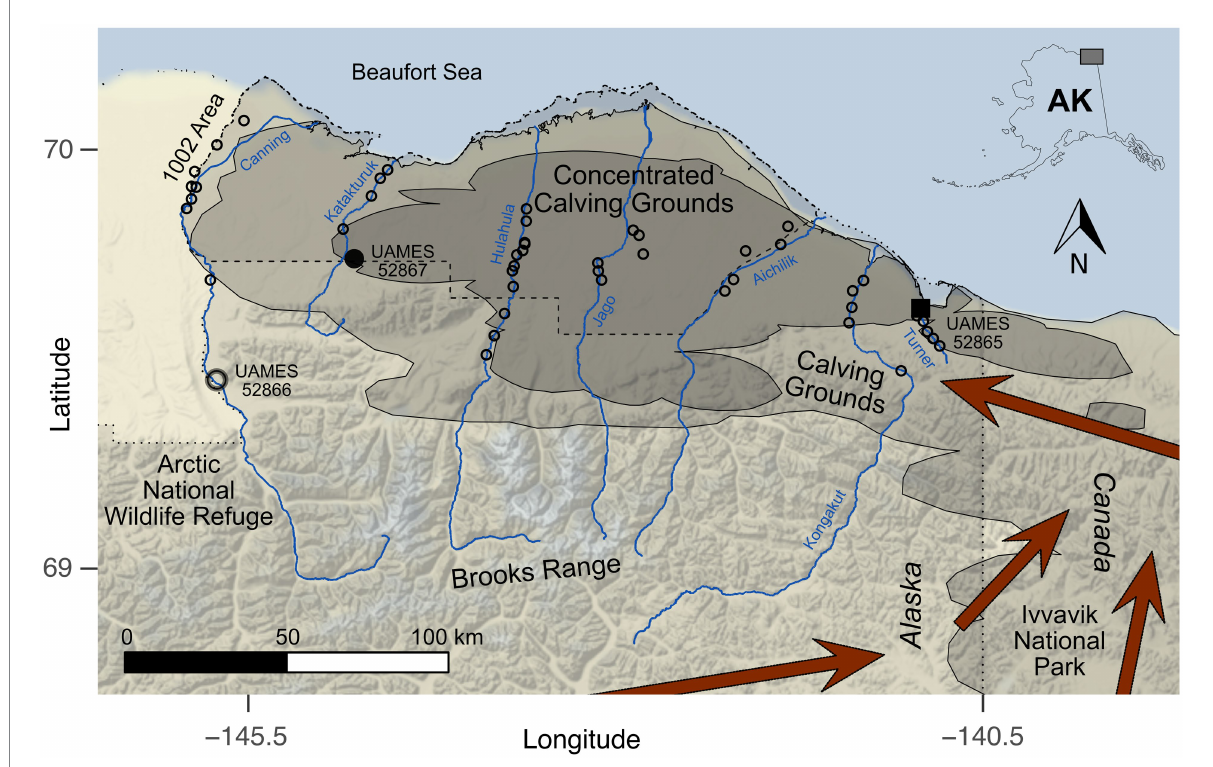
FIGURE 1 Map of the calving grounds (Alaskan) and nearby environments for the Porcupine Caribou Herd (PCH). Demarcation of the PCH calving grounds (lightly shaded region) and concentrated calving grounds (darker shaded region) are based on monitoring records (Griffith et al., 2002; Caikoski, 2020). Boundary of the Arctic National Wildlife Refuge and the “1002 Area” identified by dotted and dashed lines, respectively. Blue lines identify rivers used as transportation corridors during antler surveys: Canning, Katakturuk, Hulahula, Jago, Aichilik, Kongakut, and Turner. Locations of radiocarbon dated antlers identified by a large open circle (UAMES 52866), a large filled circle (UAMES 52867), and a large filled square (UAMES 52865). Locations of additional antler surveys are shown as small open circles. Dark red arrows identify generalized major spring migration routes to the calving grounds (Fancy et al.,